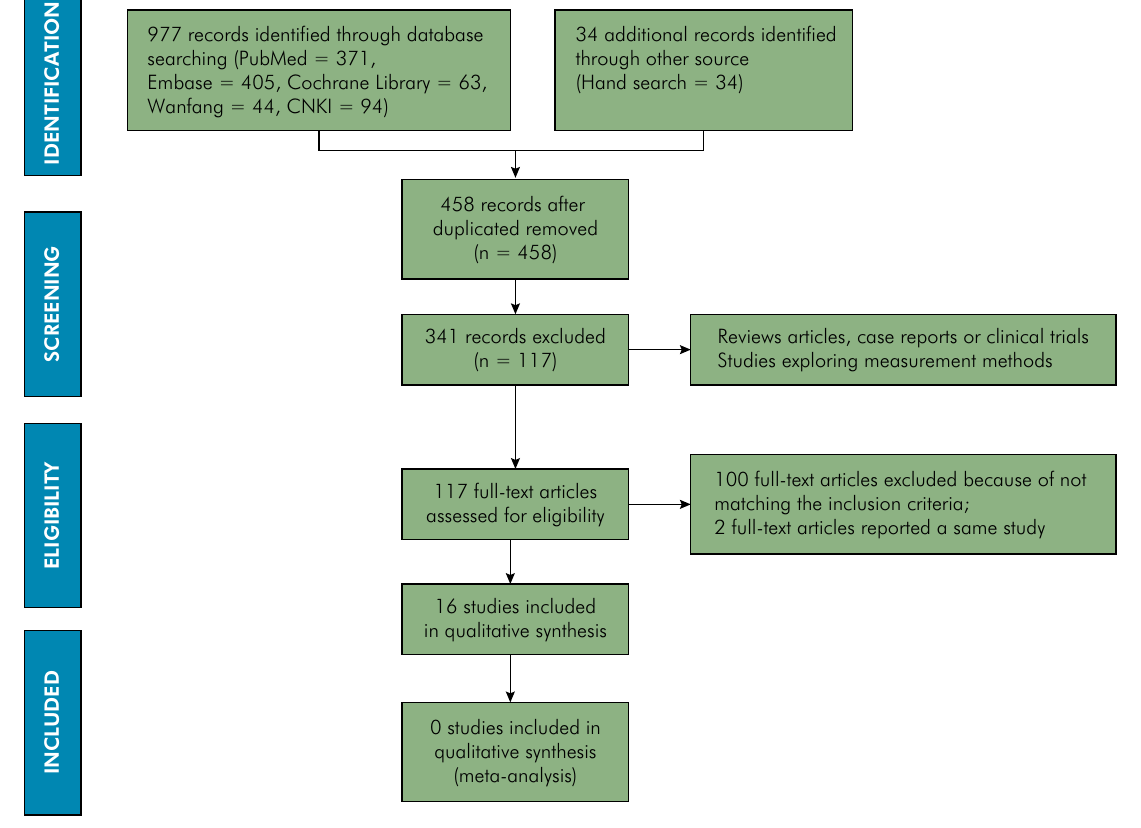
Figure 1. PRISMA flowchart of study